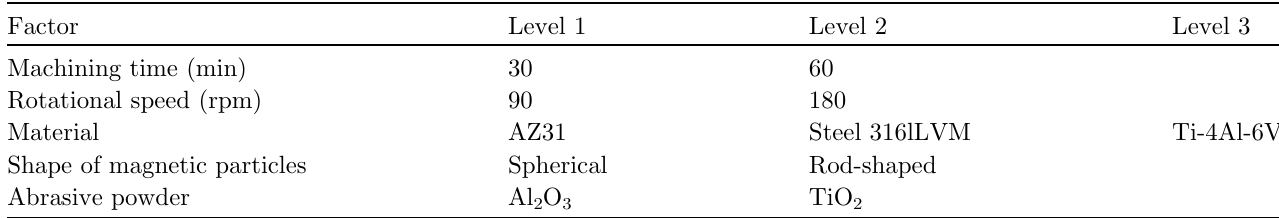
Table 2. Experiment factors and their